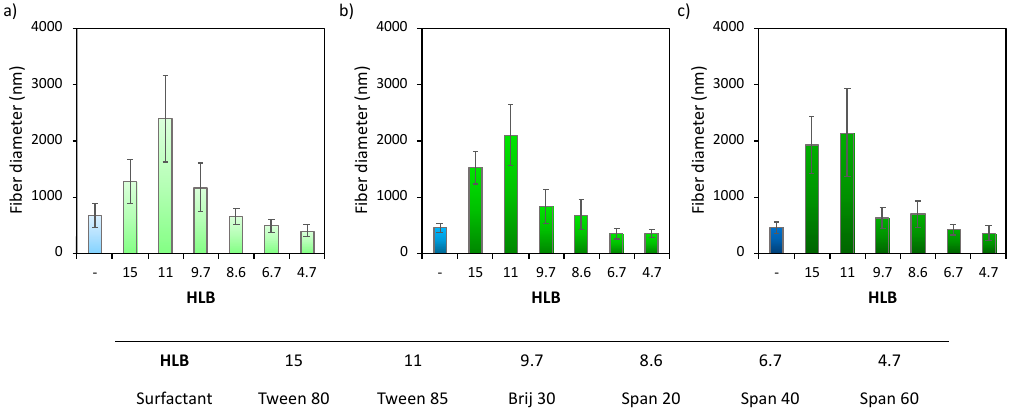
Figure 8. The effect of the surfactants (Tween 80, Tween 85, Brij 30, Span 20, Span 40, and Span 60) with different HLB values on the diameter of Pc PAL loaded PLA nanofibers at different Pc PAL loading: ( a ) 0.10, ( b ) 0.15, and ( c ) 0.20 w/w%. Size distribution of fibers was calculated from n = 50 measurements, the difference between emulsifier-free (colored with blue bars on Panel ( a – c ) and samples with emulsifier is significant ( p < 0.005) in all cases, except samples with Span 20 at